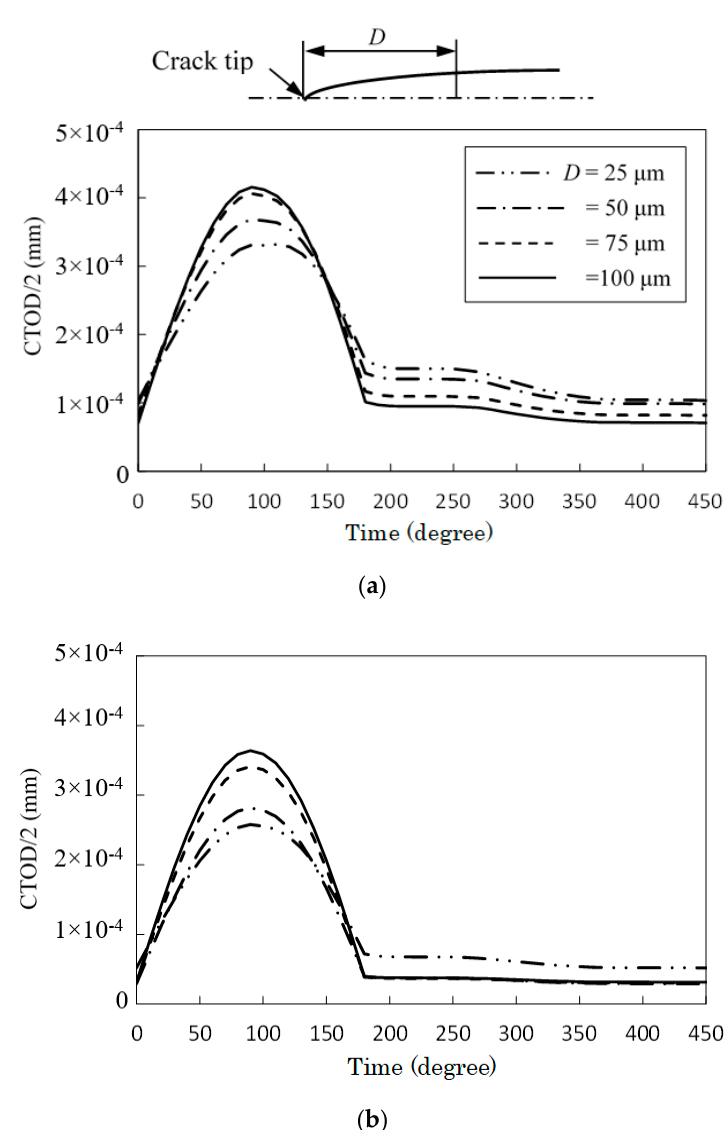
Figure 21. Variations of half the crack tip opening displacements behind the crack tip at 160th cycle of ( a ) RP and ( b ) RF. ( Δ K III / Δ K I = 1.5, δ = 90°).